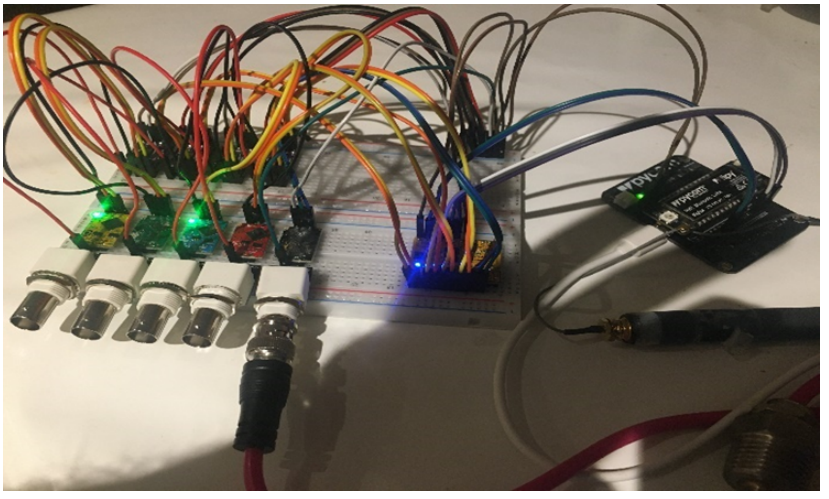
Figure 5. Early Prototype.